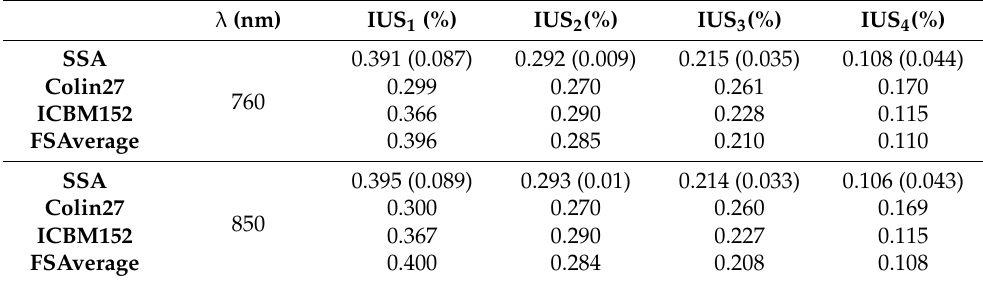
Table 3. Summary of percentage Integral Under the Surface (IUS) of SDSs at increasing quartile of cortical depth across all channels. Reported values are expressed as median (IQR) across all SSAs.